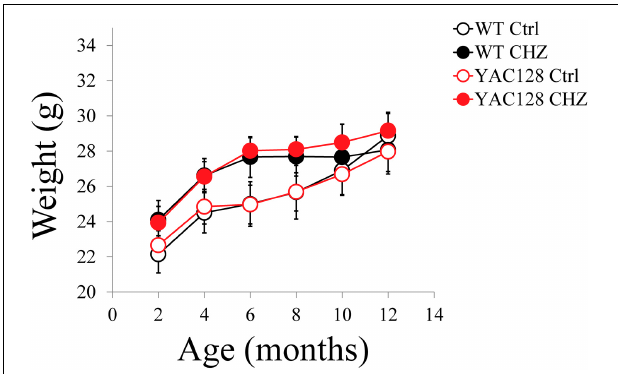
FIGURE 5 | Average body weight for WT and YAC128 mice in control and CHZ treatment groups was calculated and plotted as mean ± SE. Number of mice, m = 9 for WT Ctrl mice, m = 11 for YAC128 Ctrl mice, m = 12 for WT CHZ mice, and m = 12 for YAC128 CHZ mice. No statistically significant difference was